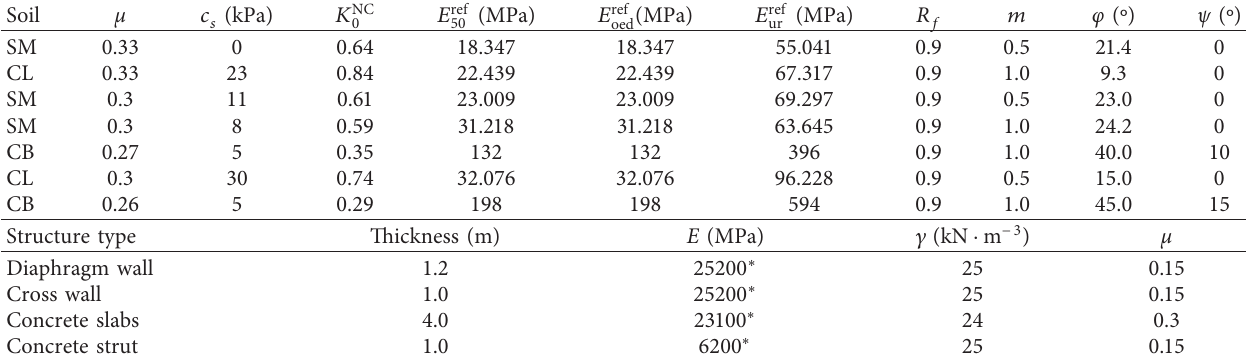
Table 5: Input parameters of the soil layer and structural members for the YDM excavation.